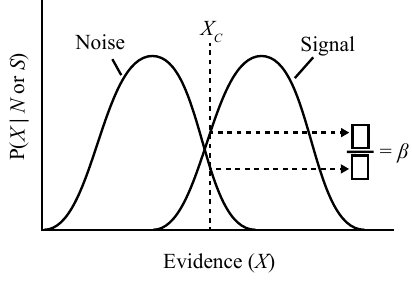
Figure 5. Visual overview of signal detection